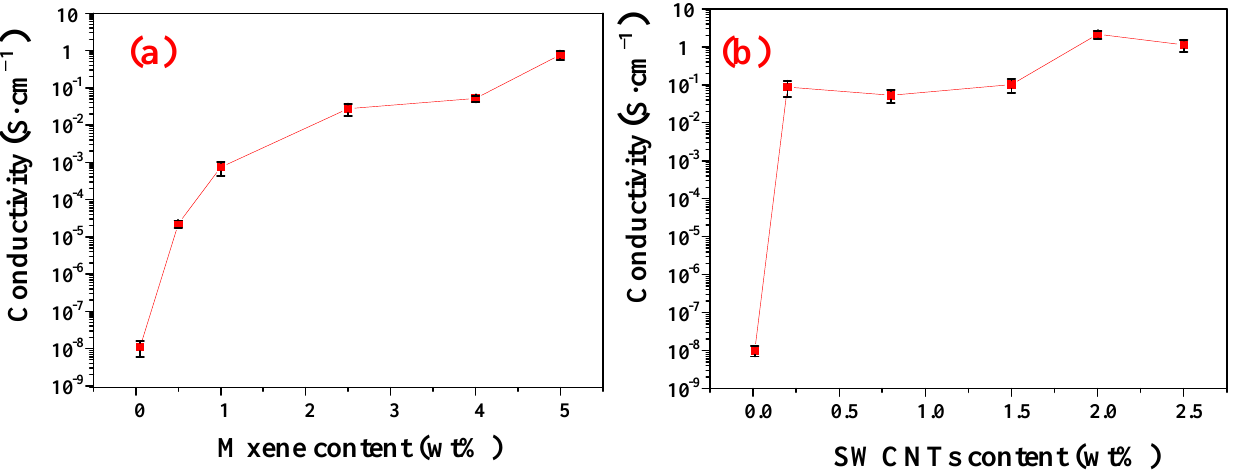
Figure 4. ( a ) Conductivity of PVDF/MXene composites versus MXene volume fraction; ( b ) conduc- tivity of PVDF/SWCNTs composites versus SWCNTs volume fraction.